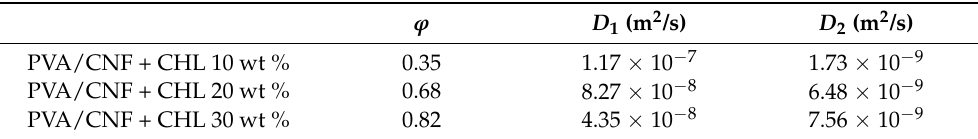
Table 3. Parameters obtained by fitting Equation (5) to experimental release